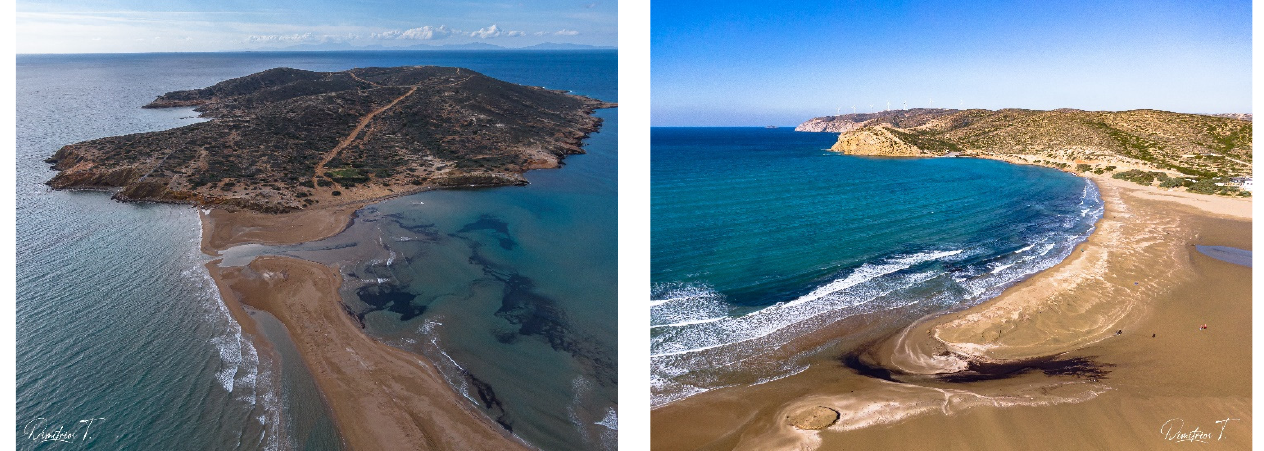
Figure 3. Recent photographs showing the changeable shape of Prasonisi’s tombolo, taken on 27 December 2021 ( left ) and on 2 January 2022 ( right ) by Dimitrios Touvras. The mean seafloor slope at the northwestern side of the tombolo is 1%, which is about half of that at the southeastern side (2%). The nearshore zone from both sides of the tombolo consists of medium-to-fine sand, while seagrass meadows are absent at depths shallower than 20